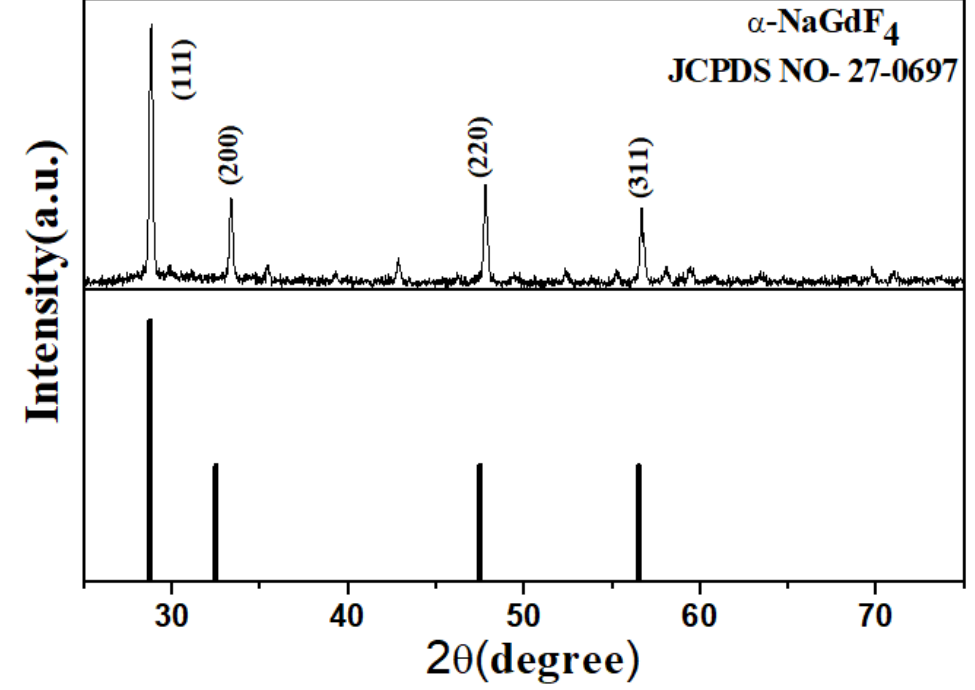
Figure 1. The XRD analysis of NaGdF 4 : Er 3+ /Yb 3+ phosphor particles for α-phase